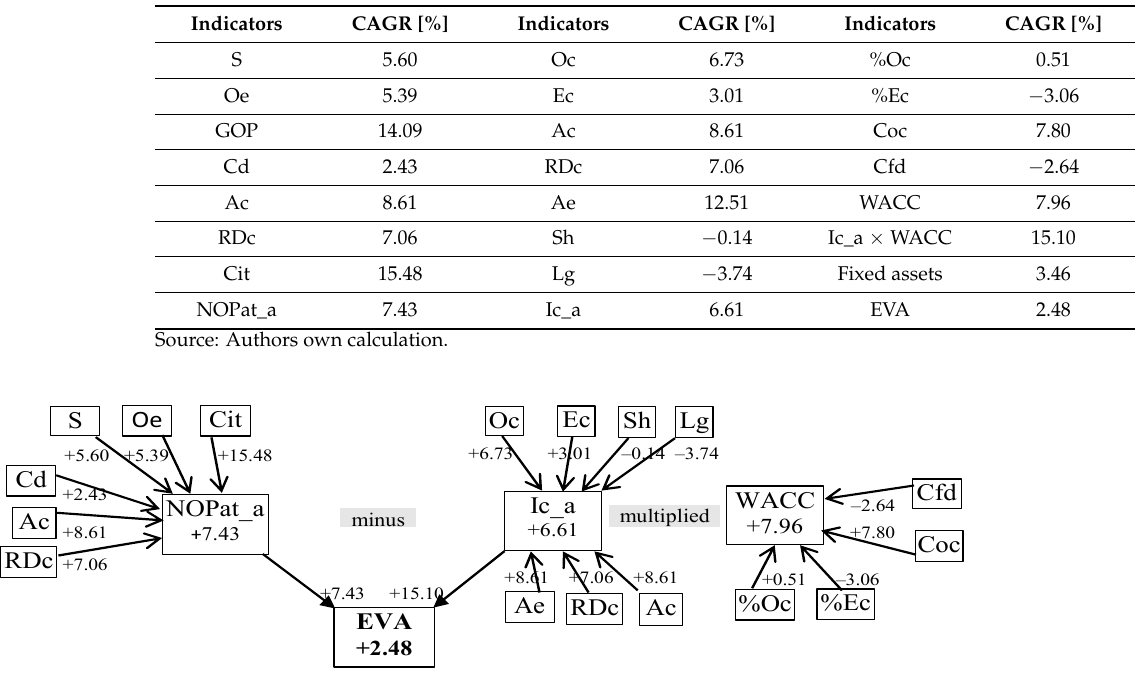
Figure 1. The impact of the variation of economic added value (EVA) determinants (compound annual growth rate (CAGR) [%]). Source: Authors own representation.